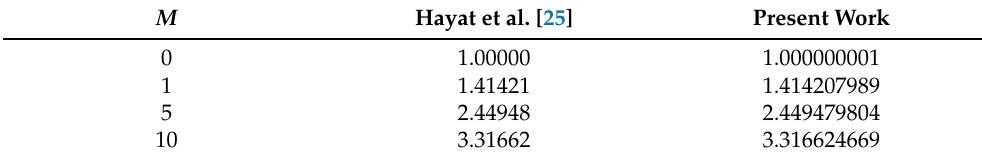
Table 1. Comparison of skin-friction values Cf x Re 1 2 with the results of Hayat et al. [25]. M Hayat et al. [25] Present Work